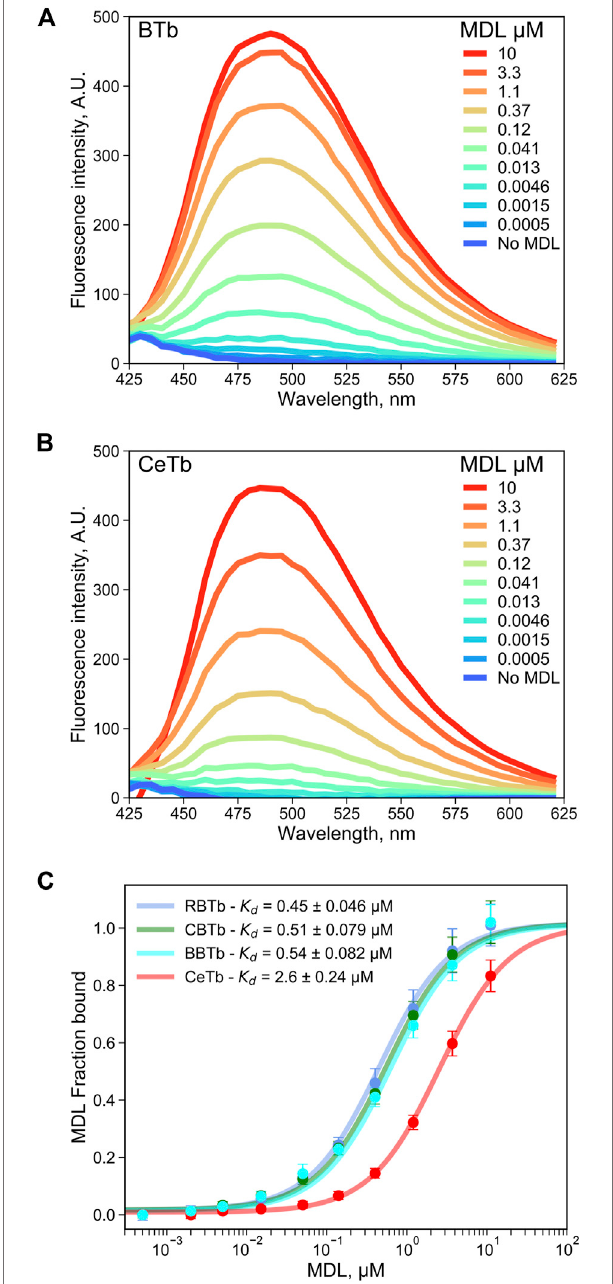
FIGURE4| Determinationofthedissociationconstantfortubulin — MDL interaction. The fl uorescence enhancement of MDL upon binding to tubulin from brain (A) or from erythrocytes (B) , both at 1 μ M, was monitored by recording the fl uorescence emission spectra with excitation at 400 nm. (C) the MDL concentration-dependent change in the fl uorescence intensity at 550 nm was used to determine the dissociation constant by non-linear regression using Eq. 1 . The binding isotherms of tubulin extracted from chicken erythrocytes (CeTb) is compared with tubulin extracted from rat brain (RBTb), from chicken brain (CBTb and from cow brain (bovine, BBTb). The data points are the averages of three to four samples and the error bars are standard deviations. The best- fi t K d are shown with the standard errors of the fi ts.